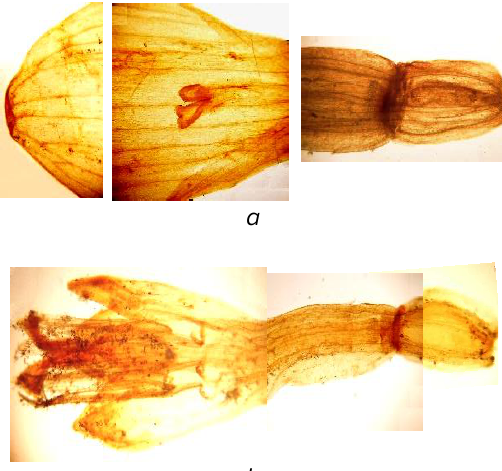
Fig. 2. Fragments of Chrysanthemum × hortorum Bailey flowers of Pectoral variety: a – false-ligulate flower;